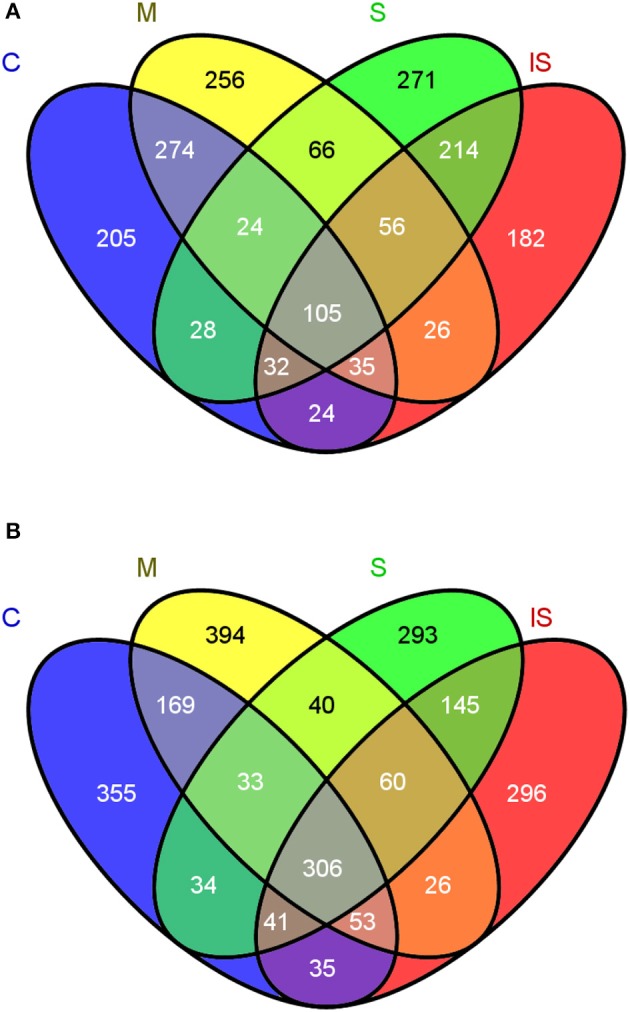
Venn diagrams indicating the numbers of shared and unique OTUs between the conducive soil (C), mixed soil (M), suppressive soil (S), and pathogen-inoculated suppressive soil (IS) in fungal (A) and bacterial communities (B).